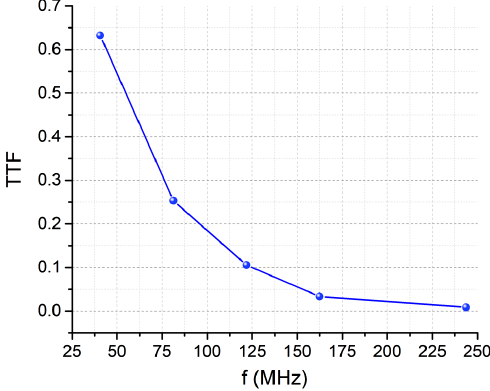
FIG. 33. Initial separatrix of the longitudinal motion and the simulated longitudinal distribution with space charge effect FIG. 32. Frequency versus TTF.